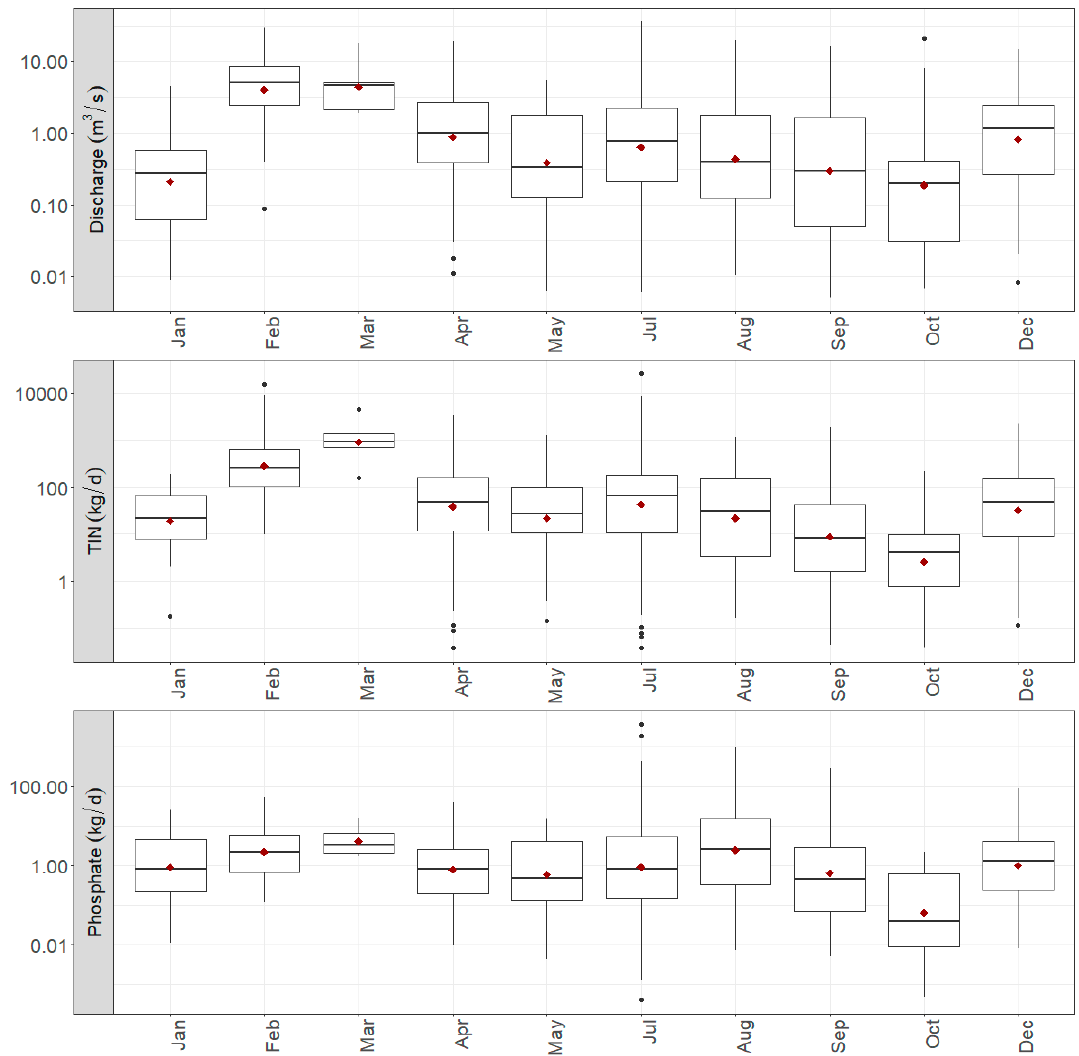
Figure 7. Boxplots of discharge (log. scaled) total inorganic nitrogen load (log. scaled) and inorganic phosphorus load (log. scaled) showing the monthly variation. The red dot indicates the mean value.